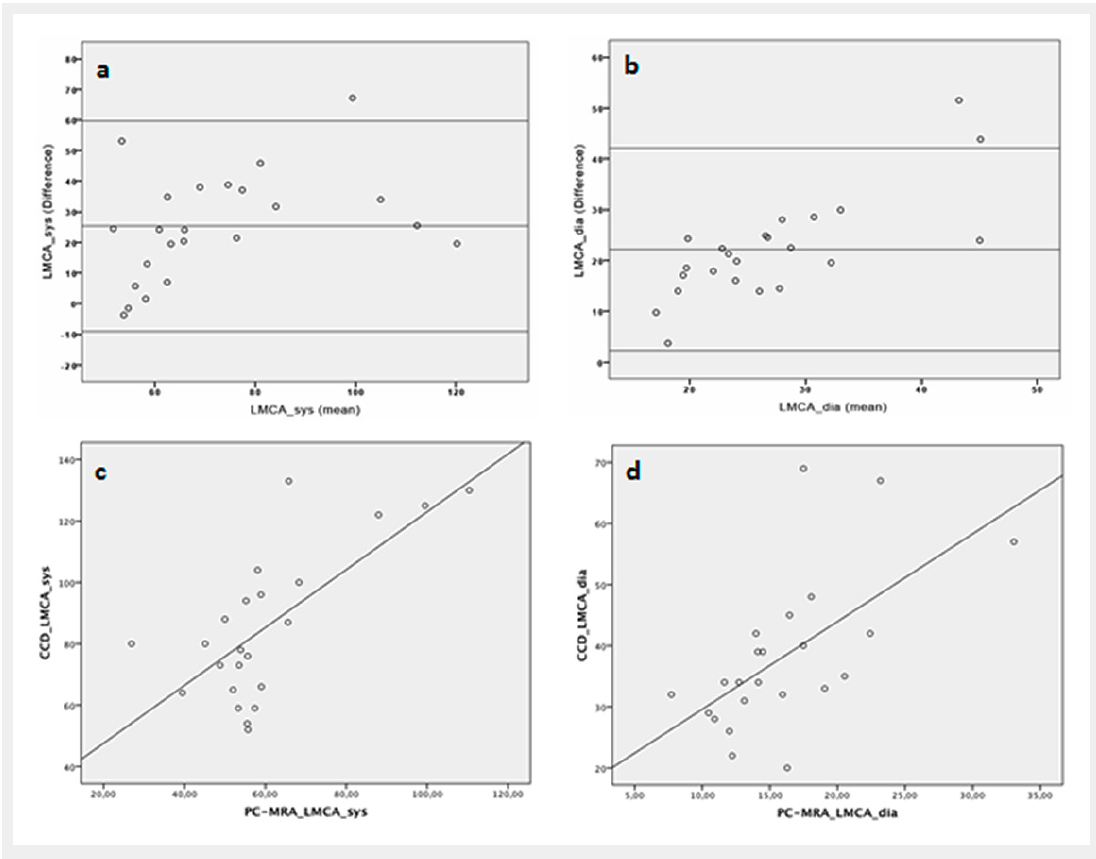
Figure 4 Bland-Altman analysis of colour-coded duplex sonography (CCD) compared with phase contrast magnetic resonance angiography (PC-MRA) of the left middle cerebral artery (MCA) showed 22 of 23 points within 1.96 for peak systolic velocity (PSV) (a) with a bias of 19.55 and 1.96 standard deviations limits of agreement of –7.44 and 46.54 and 21 of 23 points within 1.96 SD for end diastolic velocity EDV (b) with a bias of 6.68 and 1.96 SD limits of agreement of –3.00 and 16.36. The Spearman’s r for PSV was 0.555 (c) and for EDV was 0.673 (d), both significant at the 5%